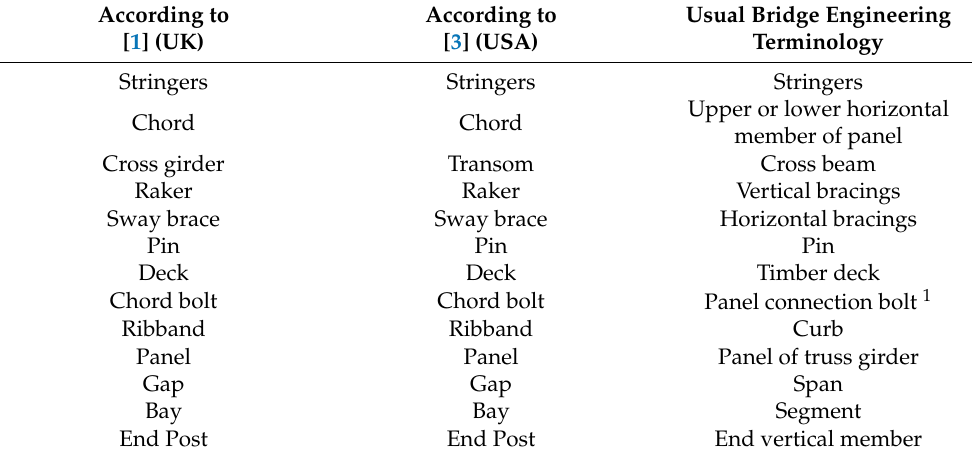
Table 1. Nomenclature of Bailey bridge